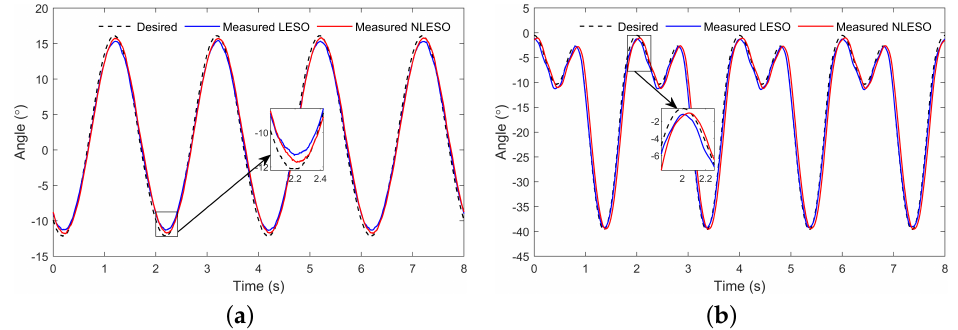
Figure 3. Comparison of the results of tracking the gait-pattern trajectory with the LESO-based and NLESO-based controller: ( a ) hip and ( b ) knee joints.